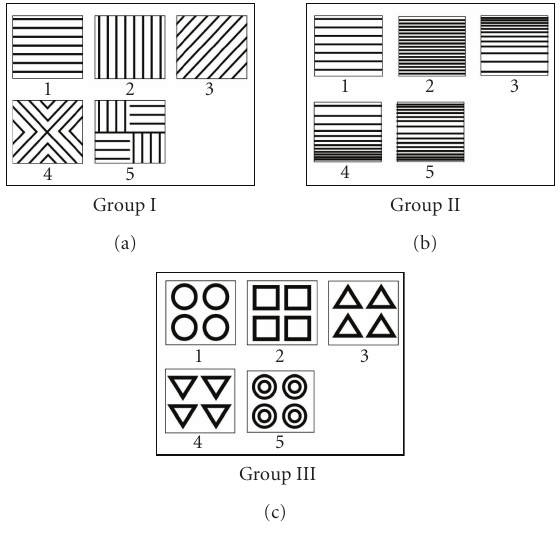
Figure 11: Texture samples.